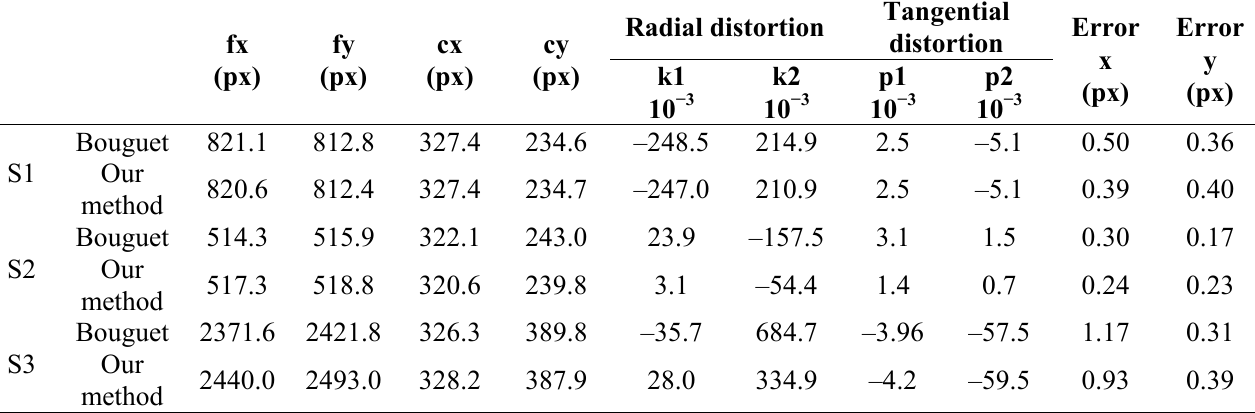
Table 1. Comparison of the calibration values between the Toolbox of Matlab of Bouguet and this method.